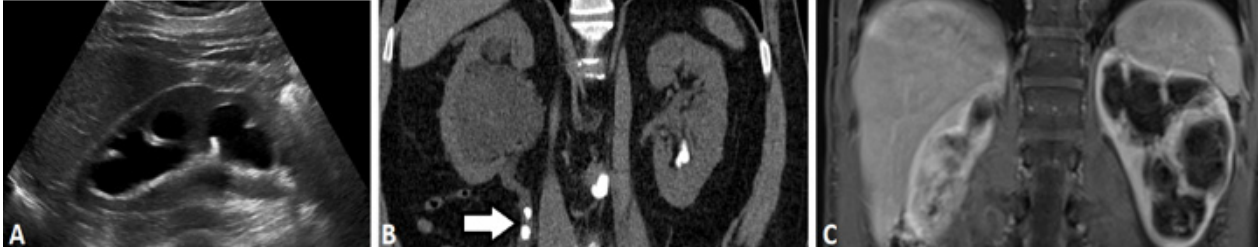
Figure 2. Different imaging modalities of kidney including right renal ultrasound ( A ), coronal non-contrast CT ( B ) and contrast enhanced MRI ( C ) demonstrating unilateral hydronephrosis. Note the presence of obstructing proximal uretal stones in the CT (arrow).